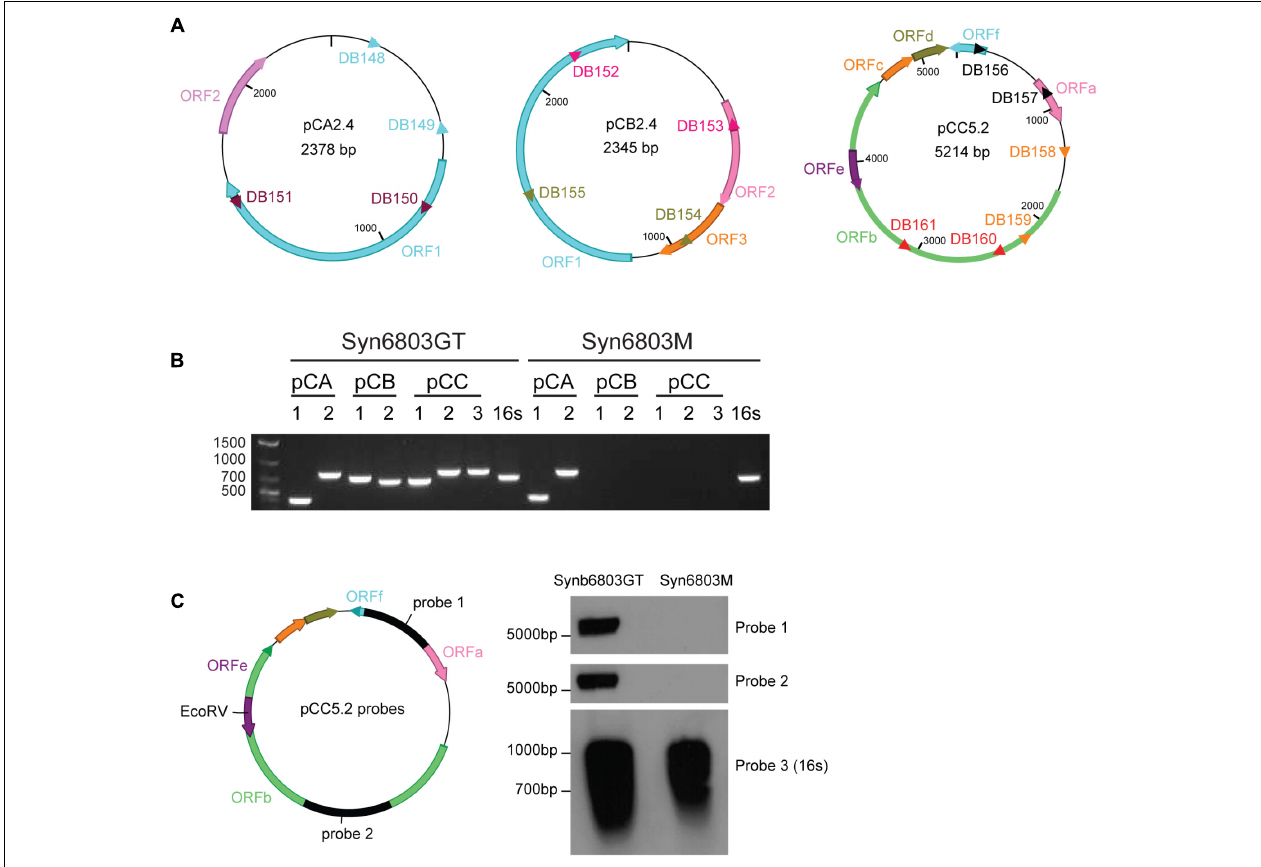
FIGURE 1 | The absence of pCC5.2 plasmid in Syn6803M. (A) Schematic of the three native small plasmids from Syn6803. ORFs on different plasmids were shown as color arrows. pCA2.4 is a 2378 bp plasmid with two predicted ORFs, ORF1 and ORF2. pCB2.4 is a 2345 bp plasmid with three predicted ORFs (1, 2, and 3). There are six predicted ORFs on pCC5.2 with ORFe contained within ORFb. PCR primer sets for the plasmid presence assay were shown as different color triangles. Primer pairs DB148 and DB149, and DB150 and DB151 on pCA2.4, DB152 and DB153, and DB154 and DB155 on pCB2.4, DB156 and DB157, DB158 and DB159, and DB160 and DB161 on pCC5.2 were designed based on plasmid sequences. (B) PCR screening for the presence of three small plasmids in Syn6803GT and Syn6803M based on primer sets from A . Primer sets (pCA 1, 2) which generated amplicons 392 and 778 bp from pCA2.4, primer sets (pCB 1, 2) which generated amplicons 701 and 645 bp from pCB2.4, primer sets (pCC 1, 2, 3) which generated amplicons 651, 787, and 790 bp from pCC5.2. All primer sets produced positive amplicons from Syn6803GT and were verified by sequencing. In Syn6803M, only the two amplicons from pCA2.4 were revealed. No amplicons from pCB2.4 or pCC5.2 were generated. Primer pair DB554 and DB555 which amplify a 660 bp fragment from 16S rRNA gene was used as a PCR positive control (16s) for both strains. (C) Probes (probe 1 and probe 2) for DNA hybridization assay of the pCC5.2 plasmid were generated from primer sets DB156 and DB157 (probe 1), and DB160 and DB161 (probe 2). Total DNA was digested with EcoRV which is a unique enzyme site on pCC5.2 and can be used for the plasmid presence assay. DNA hybridization on Syn6803GT total DNA, with both probes, generated bands around 5 kb, which is the expected linear size of pCC5.2. No band was obtained from Syn6803M total DNA, as expected. 16S rRNA probe (probe 3) was used as Southern blot positive control for both